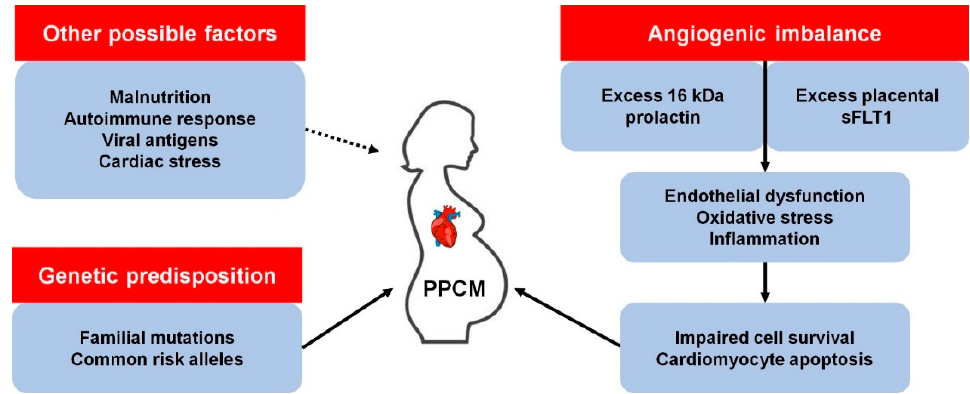
Figure 1. Known and possible mechanisms of peripartum cardiomyopathy (PPCM) pathophysiology. kDa, kilodalton; sFLT1, soluble fms-like tyrosine kinase-1.